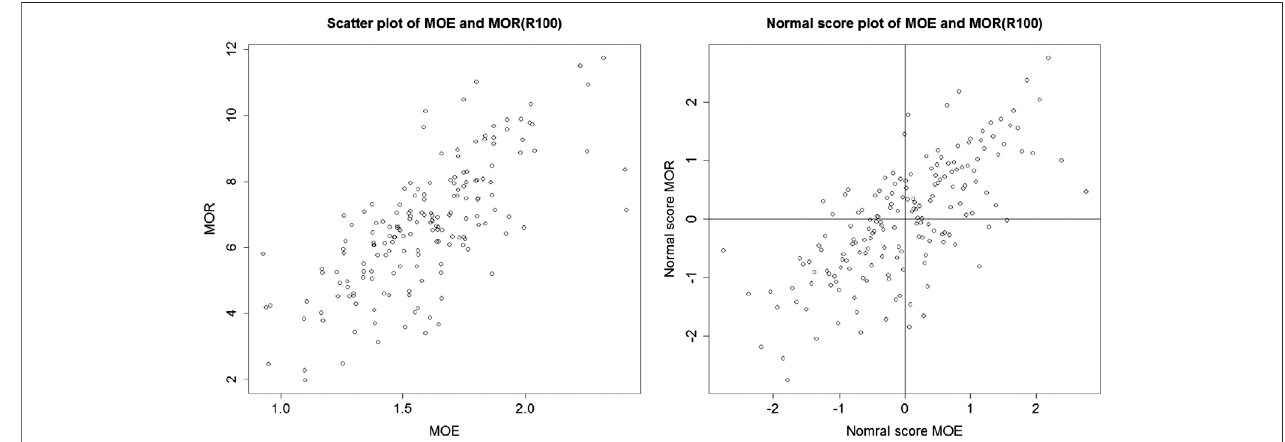
FIGURE 1 | Left: scatterplot of ( MOE , MOR ) based on R100. Right: normal scores plot of ( MOE , MOR ) based on R100.